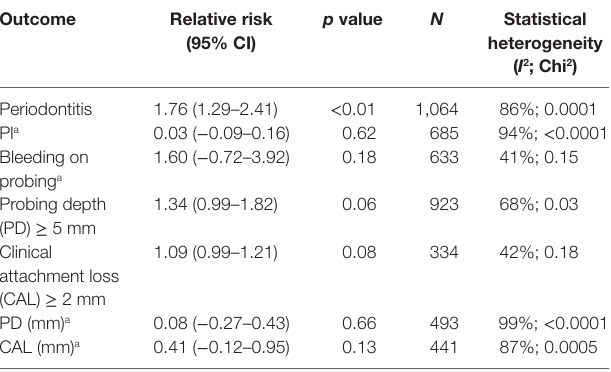
TaBle 5 | Results from